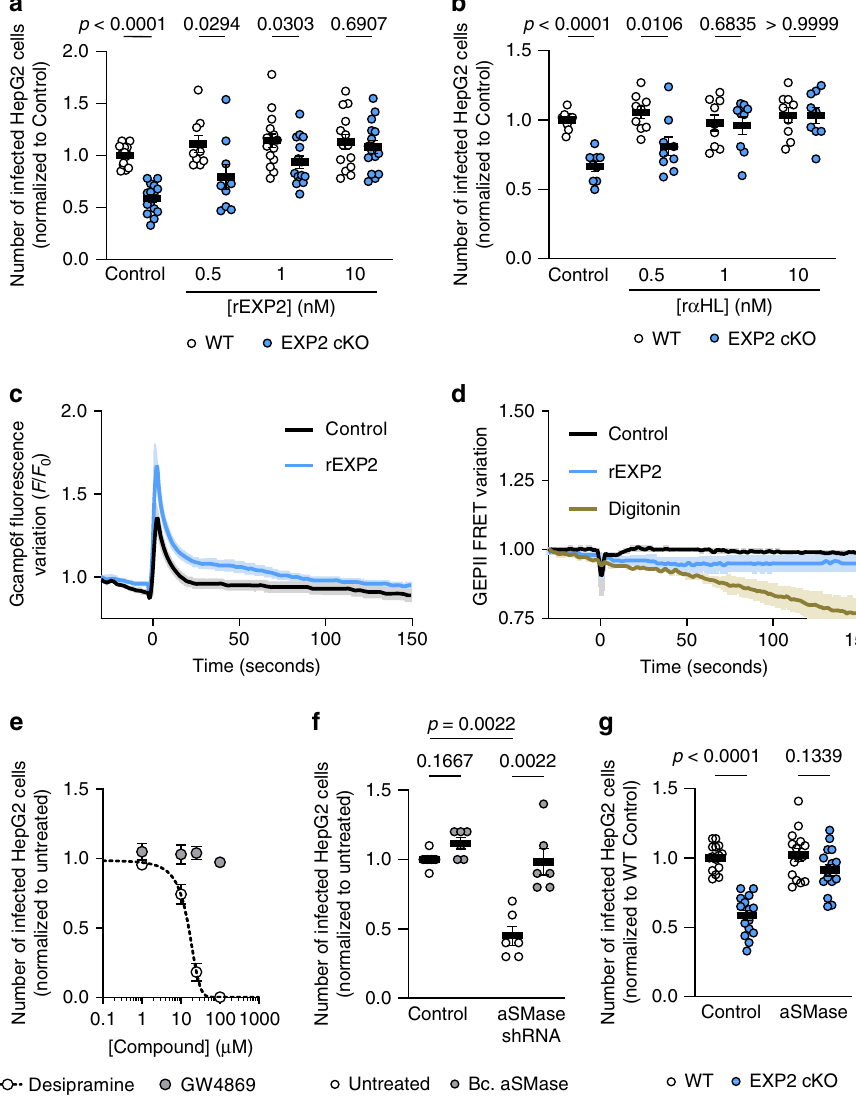
Fig. 3 Hepatocyte membrane repair is important for invasion of Plasmodium sporozoites. a Number of infected cells at 2 h after infection, infected with WT (white) or EXP2 cKO sporozoites (blue), after addition of r Pf EXP2 at 1 h after infection ( N = 5 independent experiments totaling 15 replicates for all concentrations except for 0.5 nM, where N = 3 independent experiments totaling nine replicates were performed). b Number of infected cells at 2 h after infection, infected with WT (white) or EXP2 cKO sporozoites (blue), after addition of r α -HL at 1 h after infection ( N = 3 independent experiments totaling nine replicates). c Calcium uptake by cells measured using Gcamp6f fl uorescent protein, through time after addition (at time 0 s) of 100 nM r Pf EXP2 (blue line) or vehicle control (black line) ( N = 3 independent experiments, >75 total cells imaged per condition). d Potassium ef fl ux by cells measured using GEPII fl uorescent protein, through time after addition (at time 0 s) of 100 nM r Pf EXP2 (blue line), 50 µ M of Digitonin (brown line, permeabilizes cellular membranes) or vehicle control (black line) ( N = 2 independent experiments, >50 cells imaged per condition). e Number of infected cells at 2 h after infection by GFP-expressing sporozoites in the presence of desipramine (acid SMase inhibitor, white) or GW4869 (neutral SMase inhibitor, gray) ( N = 3